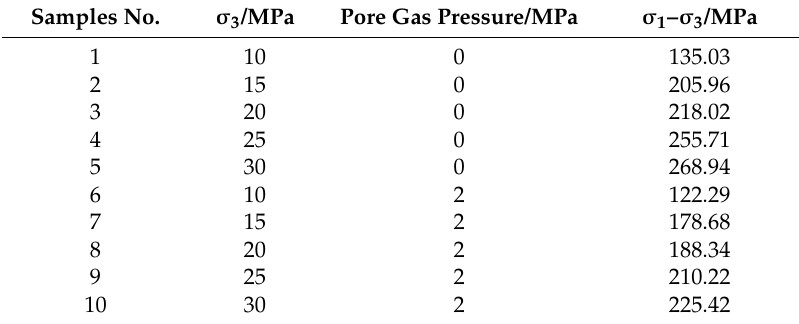
Figure 6. Stress-strain curves from triaxial compression tests under 2 MPa gas pressure condition. Table 1. Experimental strength parameters under gas pressures of 0 and 2 MPa.